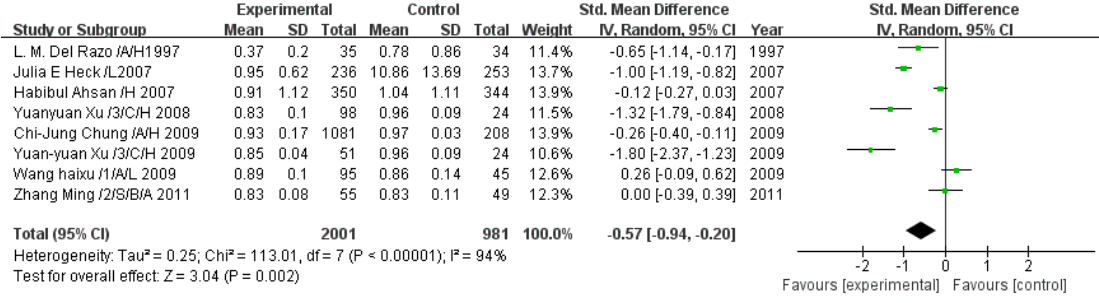
Figure 9. Effect of arsenic exposure on the primary methylation index (PMI). Std., standardized; SD, standard deviation; IV, independent variable; CI, confidence interval.